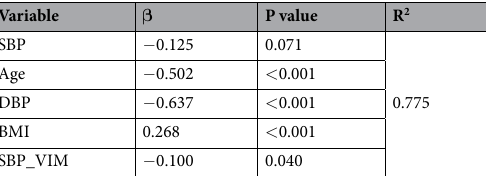
Table 5. Independent Predictors of TAC in a Stepwise Multiple Linear Regression Analysis. SBP, systolic blood pressure; DBP, diastolic blood pressure; TAC, total arterial compliance; BMI, body mass index; VIM, variation independent of mean.